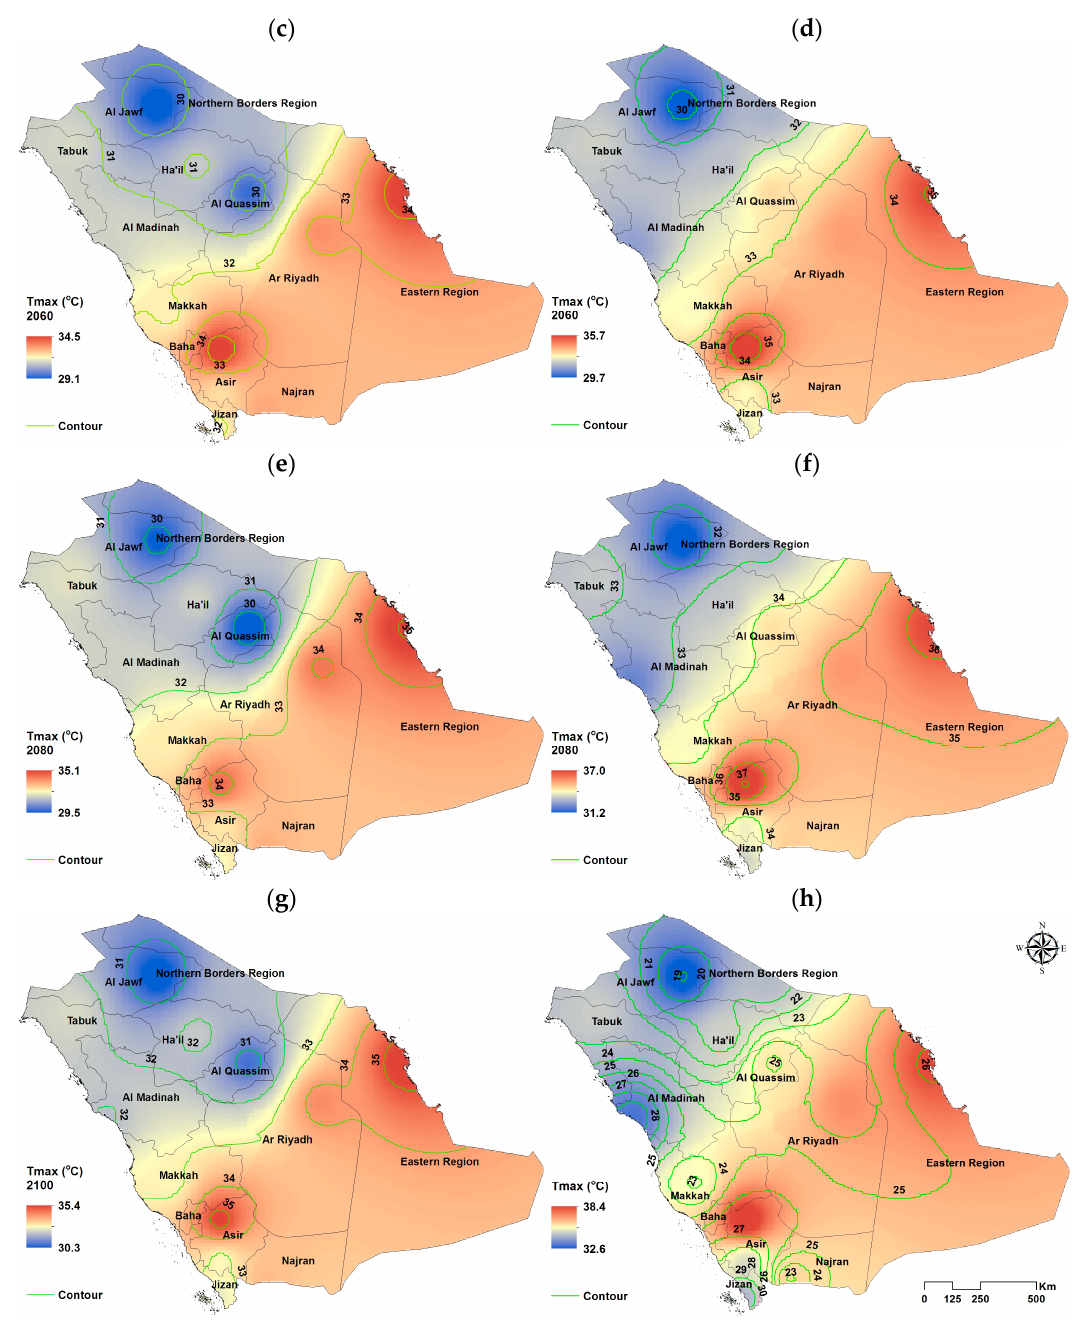
Figure 4. Annual-averaged Tmax (°C) under SSP2-4.5 on the left for ( a ) 2040, ( c ) 2060, ( e ) 2080, and ( g ) 2100 and SSP2-8.5 on the right for ( b ) 2040, ( d ) 2060, ( f ) 2080, and ( h ) 2100.